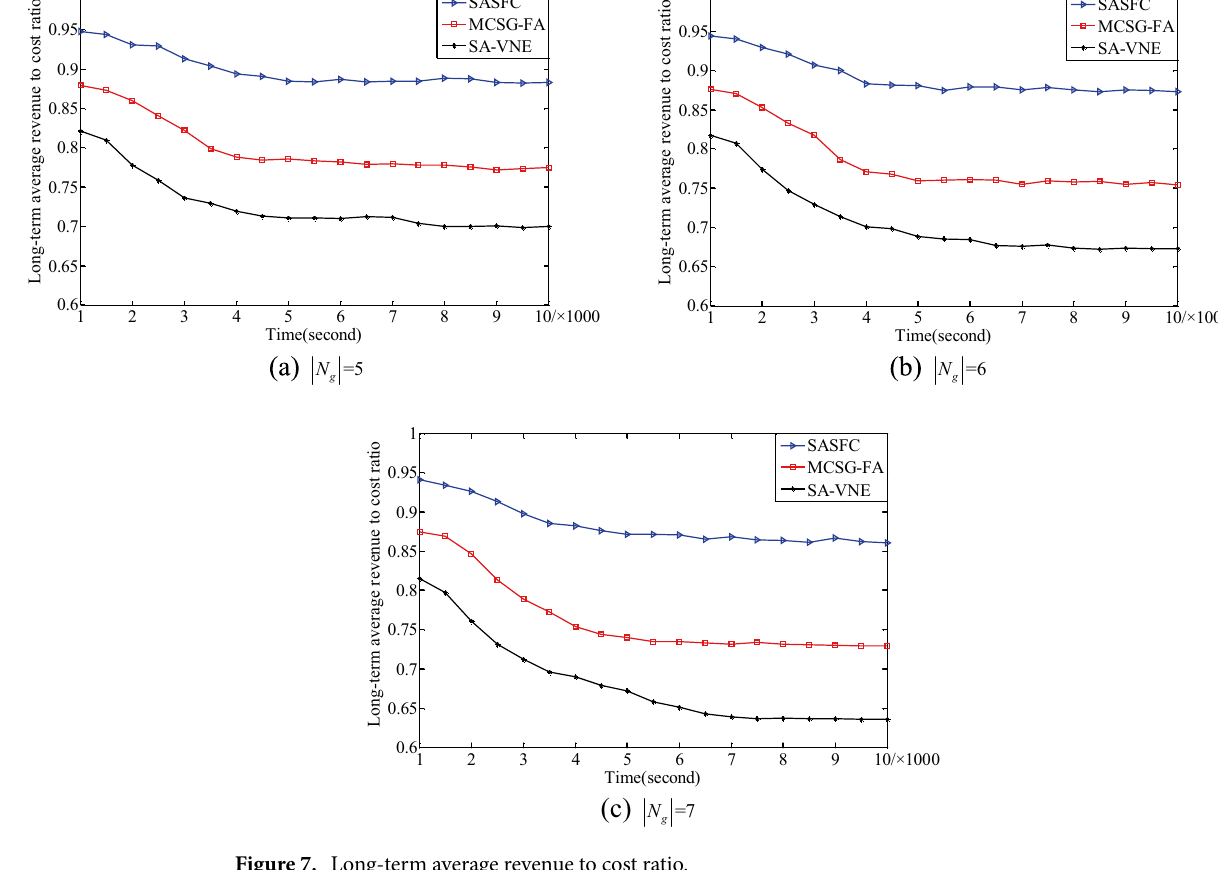
Figure 7. Long-term average revenue to cost ratio.